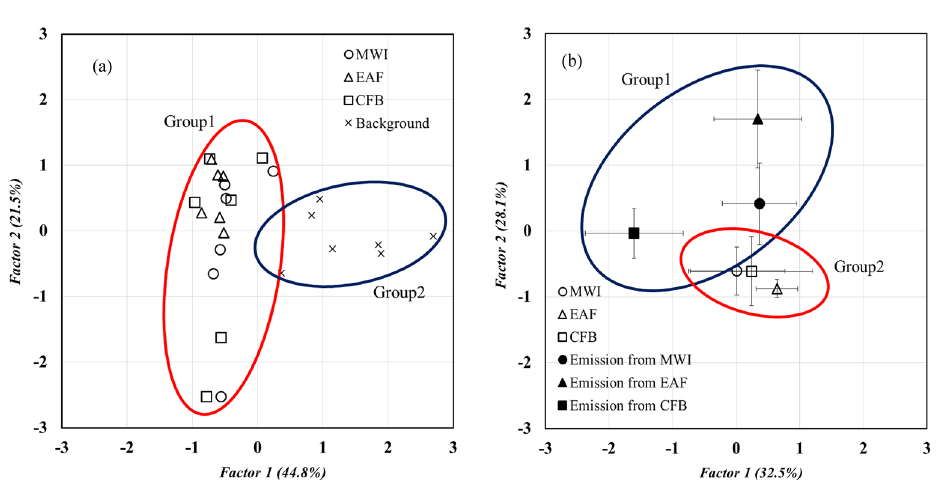
Figure 3. PCA results of atmospheric PCDD/Fs ( a ) in stationary sources vicinity and ( b ) compared with